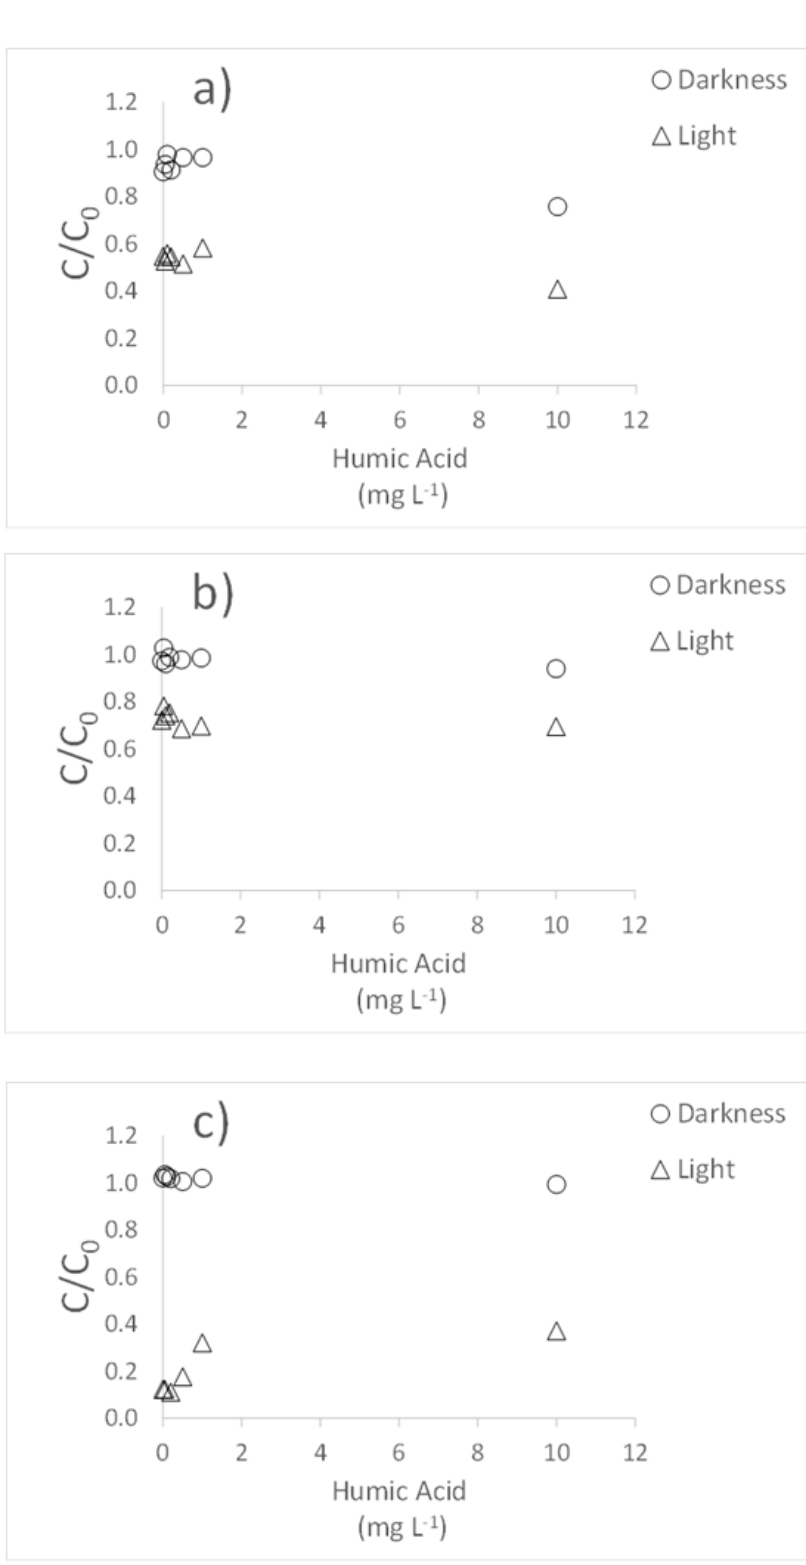
Figure 4. Influence of humic acids on the photodegradation of the three antibiotics: ( a ) Ciprofloxacin; ( b ) Clarithromycin; ( c ) Trimethoprim. C/C 0 is the fraction of the initial concentration ( C 0 ) that remains in the suspension after a given time t.